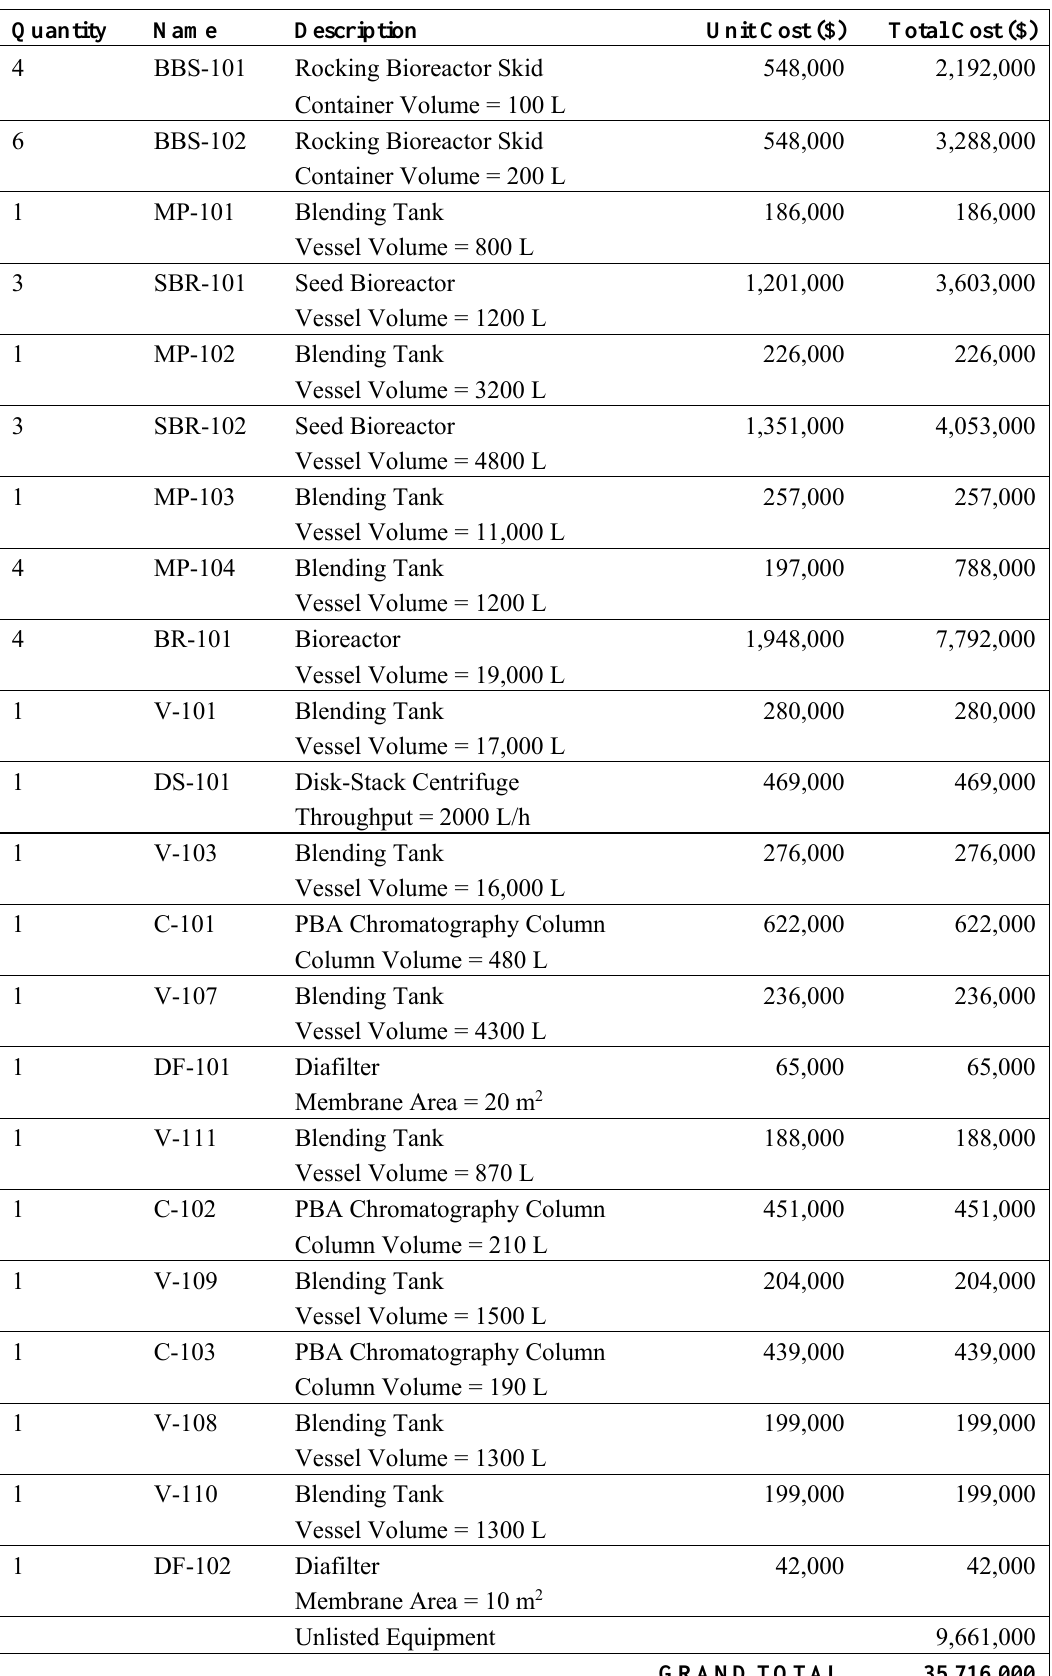
Table 2. Major Equipment Specification and Purchase Costs (Year 2013 prices in US